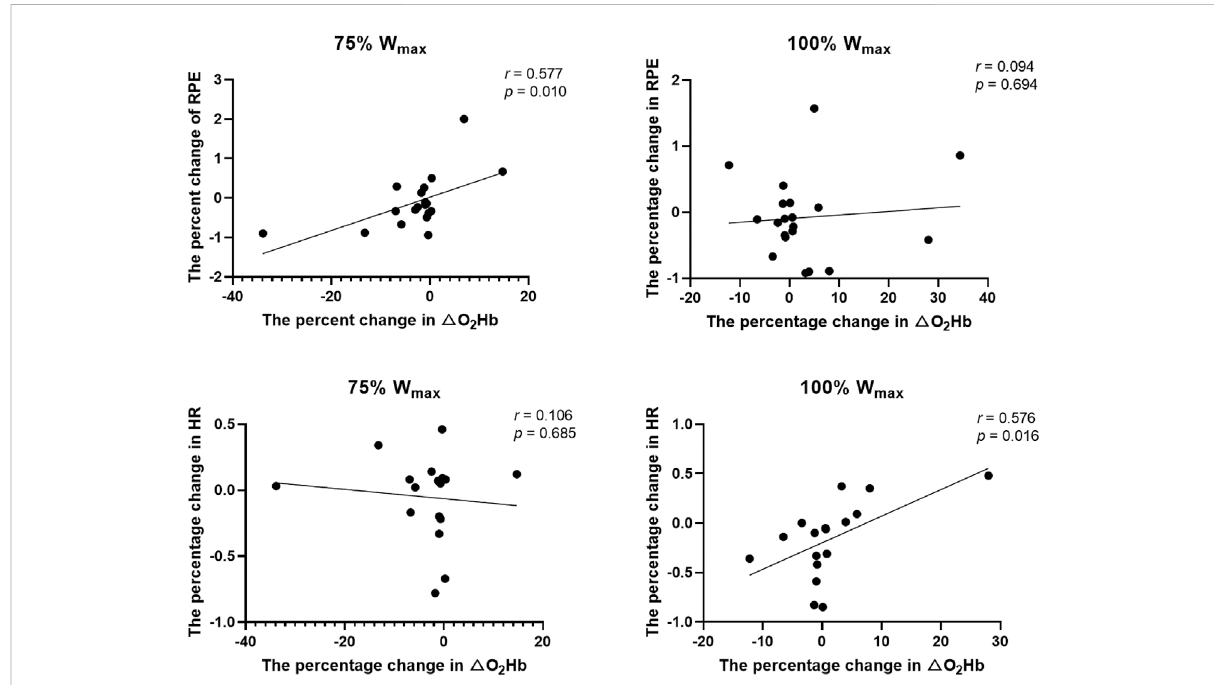
FIGURE 3 The associations between the H 2 -induced change in the PF and that of the PFC activation. Abbreviations: RPE = ratings of perceived exertion; HR = heart rate; W max = maximum